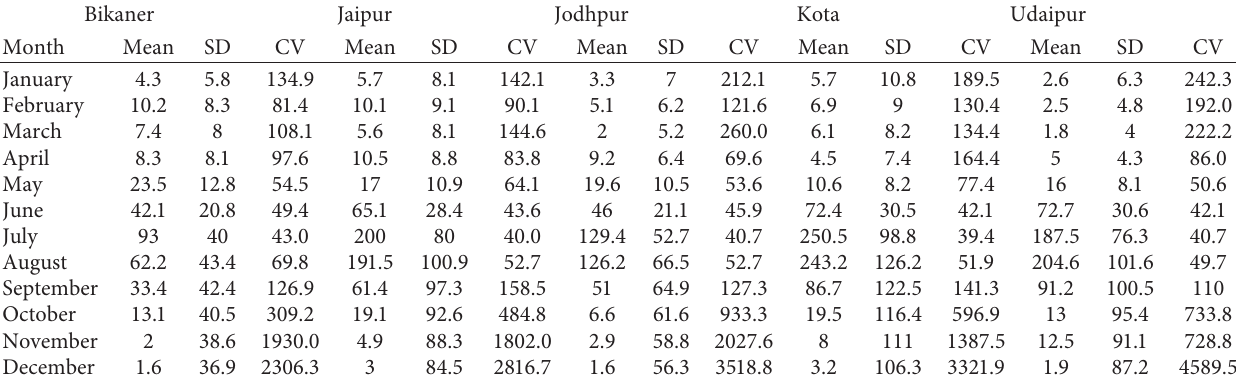
Table 2: Summary statistics for annual rainfall in mm (1971–2019) in the districts of Rajasthan.